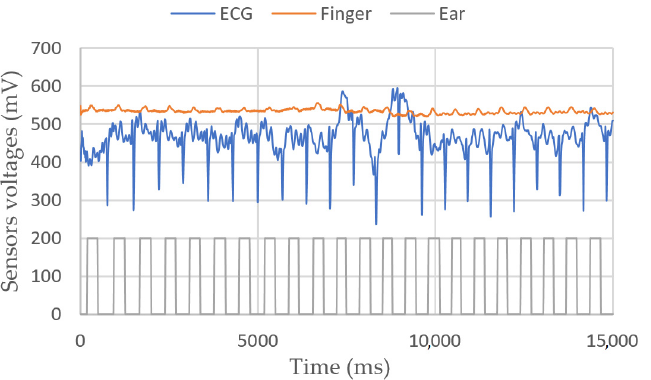
target moves their finger between 5 and 10 s, their head between 15 and 20 s, their chest between 25